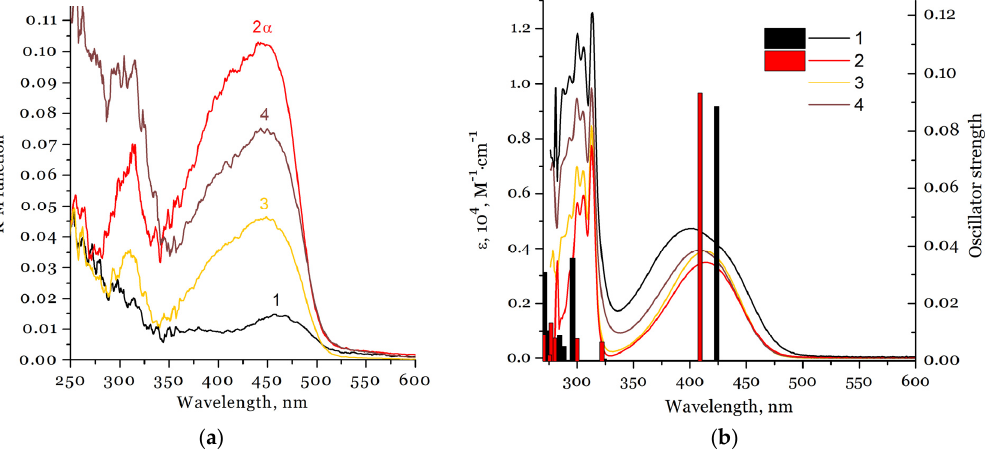
Figure 4. ( a ) UV-Vis spectra of solid samples 1 – 4 mixed with BaSO 4 in the form of Kubelka–Munk functions. ( b ) UV-Vis spectra of 1 – 4 in toluene solutions (lines) and calculated excitation S 0 –S 1 ener- gies and their oscillator strength (TD-PBE0/def2-TZVP(-f)) on the example of 1 and 2 (vertical bars). Table 1. Calculated in vacuum wavelengths for S 0 – S 1 , S 1 – S 0 , and T 1 – S 0 transitions (nm), experi- mental absorption ( λ abs ) and emission ( λ Em ) maxima (nm), emission lifetime at the given temperature ( τ , ns) and quantum yield (QY, %; the excitation at 420 nm) for compounds 1 – 4 in the solid state and toluene solution.